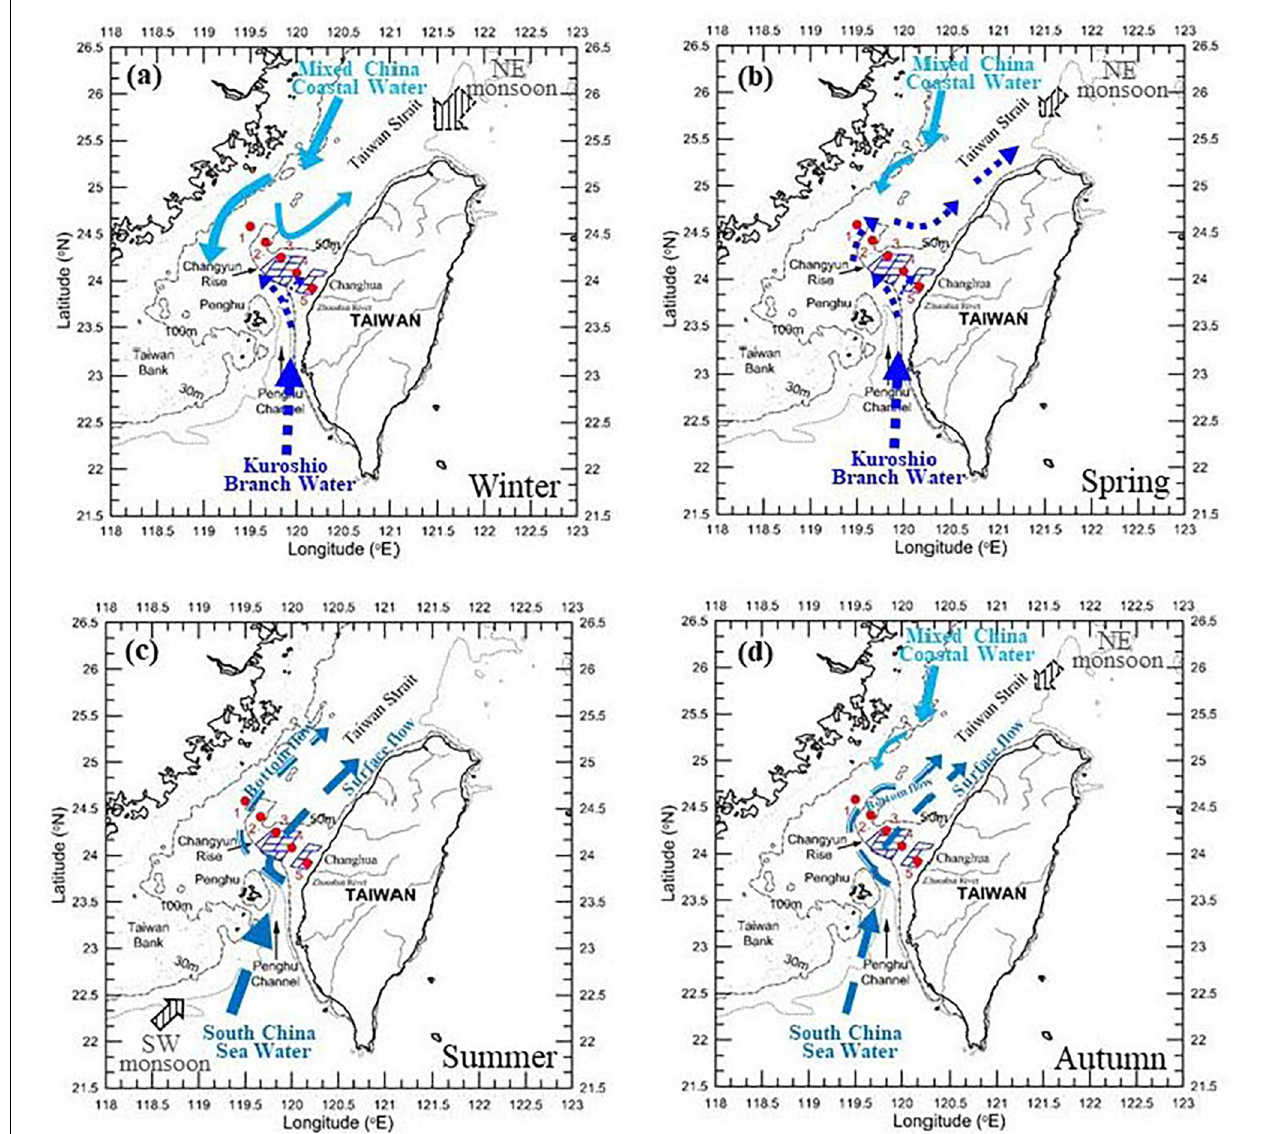
FIGURE 1 | Map of the study area and sampling stations (red dots represent the sampling stations). The areas that are framed by blue lines are designed to be offshore wind farms. The Changyun Rise is between 119.5–120.1 ◦ E and 23.9–24.6 ◦ N, where the water depth shallower than 50 m. Schematic showing the Taiwan Strait circulation in (a) winter, (b) spring, (c) summer, and (d) autumn (water currents were taken from Jan et al.,